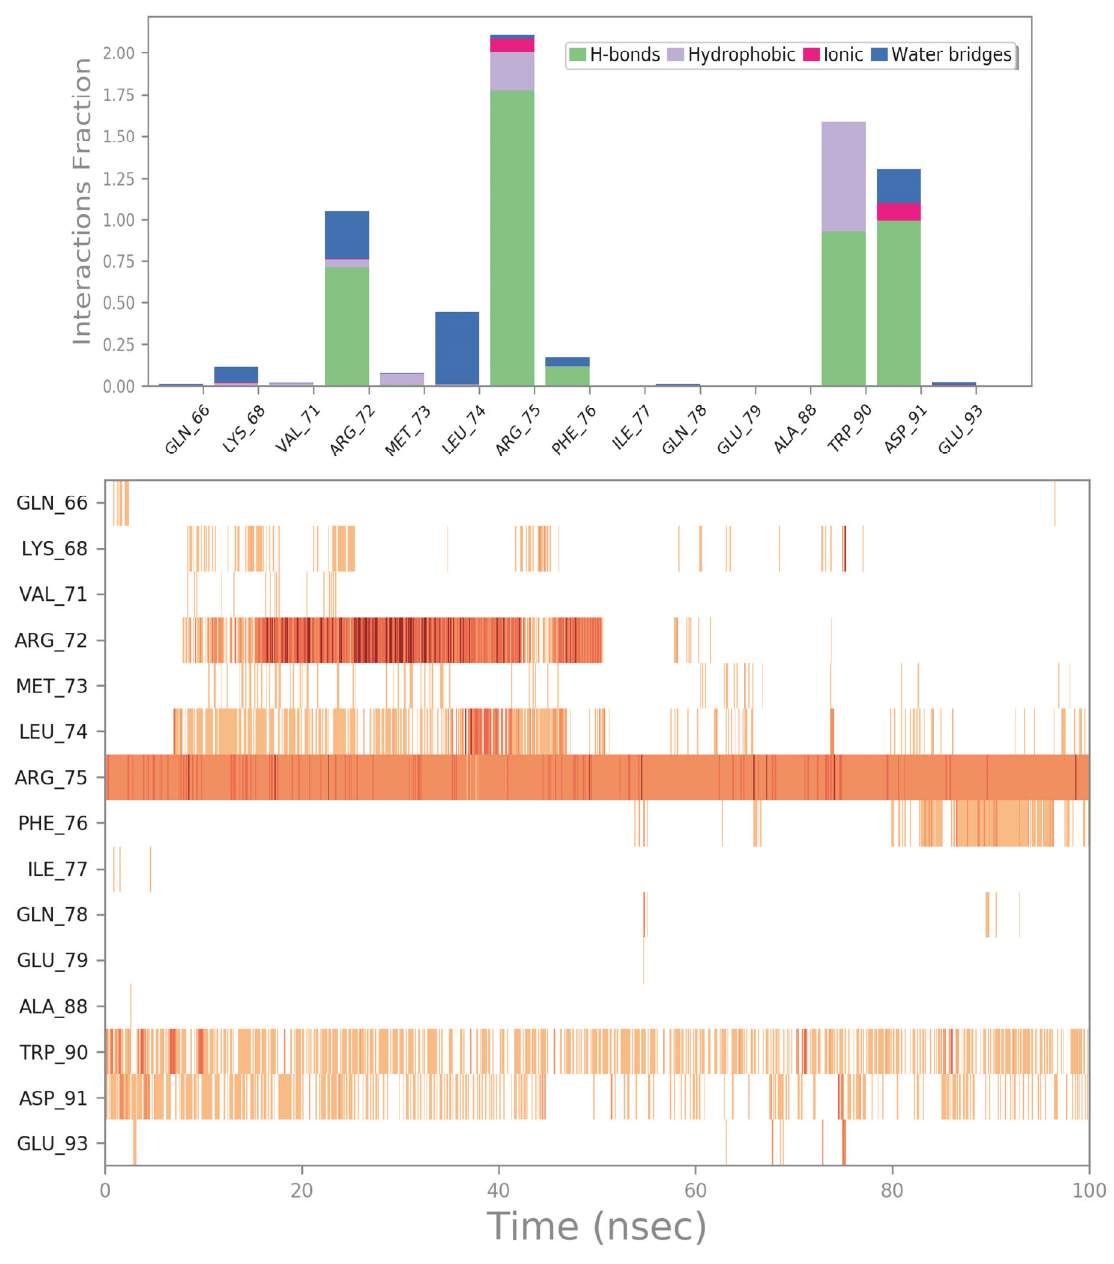
Figure 8. ZINC000003803652 monitored during the MD run. The interactions can be grouped into four types: H bonds (green), hydrophobic (grey), ionic (magenta), and water bridges (blue). The subsequent diagram of the figure illustrates a timeline description of the main interactions. A darker hue of orange indicates that some residues make many distinct contacts with the ligand (Maestro, Schrödinger LLC, release 2020-3).